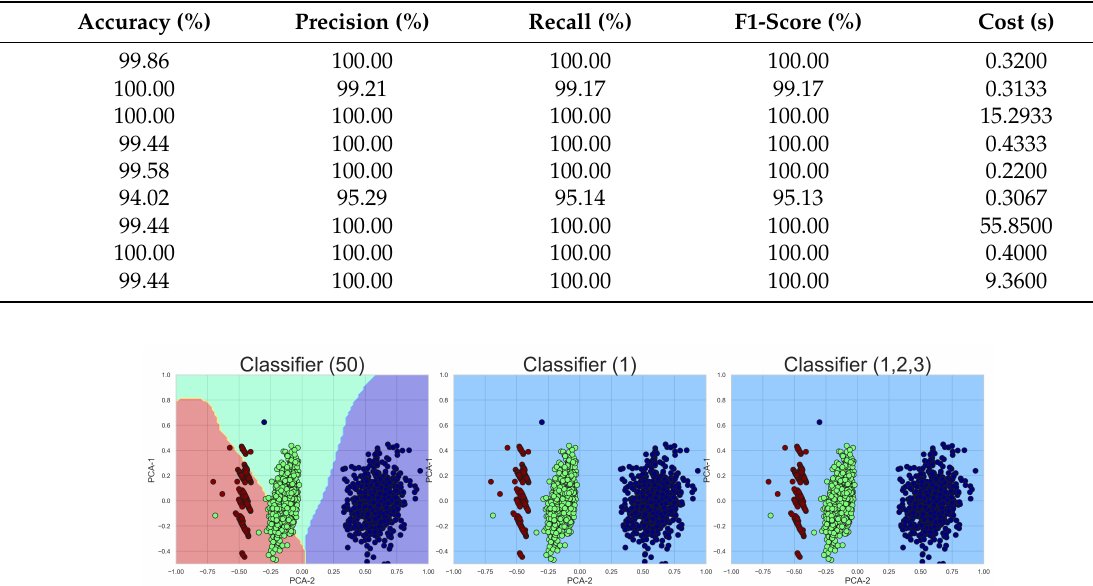
Figure 18. Fault Visualization plot aided with PCA for a capacitance dataset. Table 7. Global performance comparison of ML models using equivalent series resistance (ESR) features.